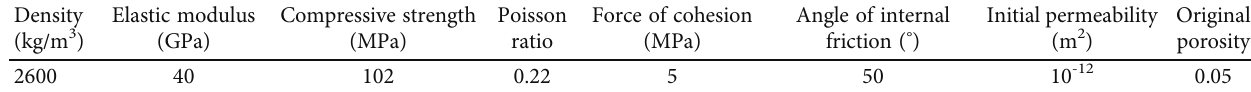
Table 2: Rock material